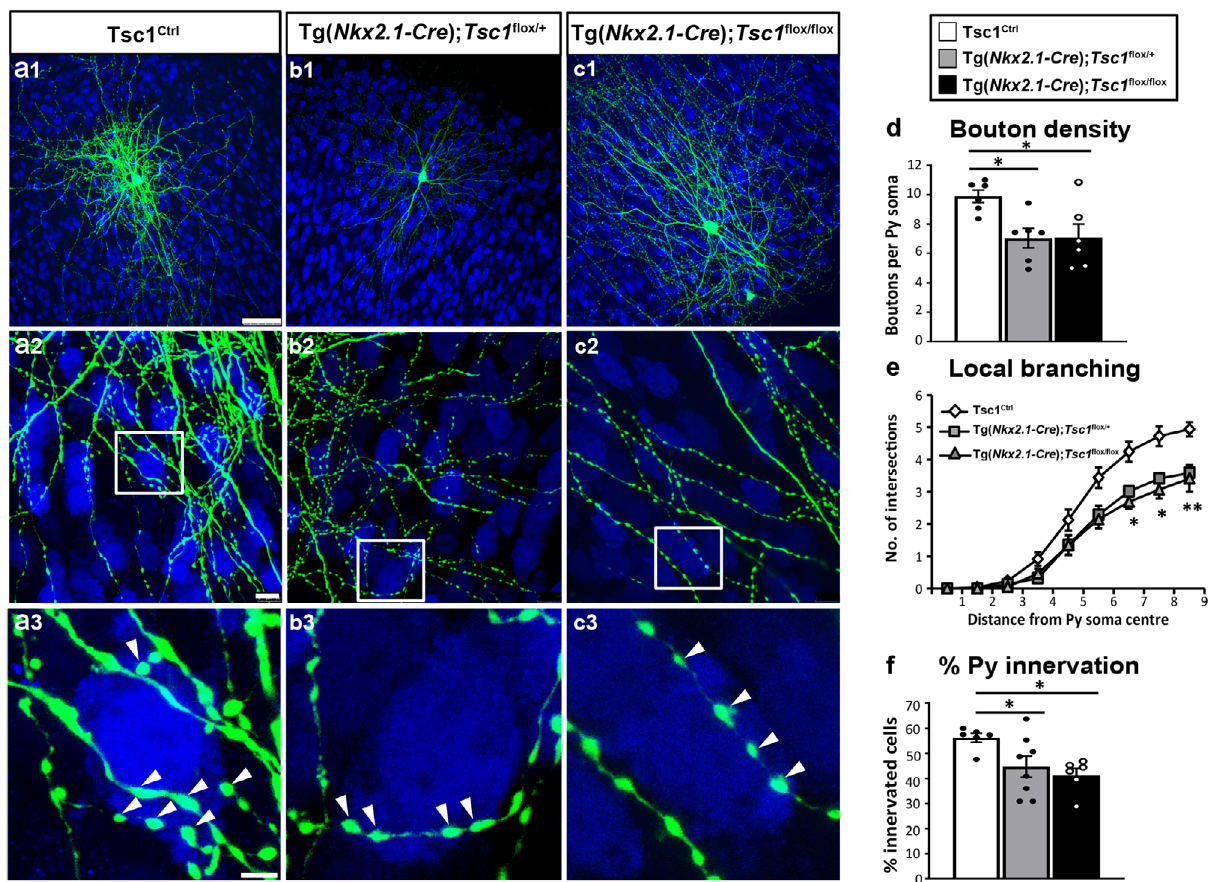
Fig. 5 PV interneurons show signi fi cantly reduced perisomatic innervation in Tg( Nkx2.1-Cre ); Tsc1 fl ox/ fl ox and Tg( Nkx2.1-Cre ); Tsc1 fl ox/ + mice at EP34. a A PV cell (green) among NeuN immunostained neurons (blue) in cortical organotypic cultures from a Tsc1 Ctrl mouse at EP34. b , c PV cells from Tg( Nkx2.1- Cre ); Tsc1 fl ox/ + mice ( b1 – b3 ) or Tg( Nkx2.1-Cre ); Tsc1 fl ox/ fl ox mice ( c1 – c3 ) show decreased bouton density ( d ) (one-way ANOVA, * p = 0.0157; Holm – Sidak ’ s multiple comparisons: Tsc1 Ctrl vs Tg( Nkx2.1-Cre ); Tsc1 fl ox/ + * p = 0,0214; Tsc1 Ctrl vs Tg( Nkx2.1-Cre ); Tsc1 fl ox/ fl ox * p = 0.0214). Local branching ( e ) (one-way ANOVA, ** p = 0.0040 (Radius 7), * p = 0.0127 (Radius 8), ** p = 0.0011 (Radius 9); Holm – Sidak ’ s multiple comparisons: (Radius 7) Tsc1 Ctrl vs Tg( Nkx2.1-